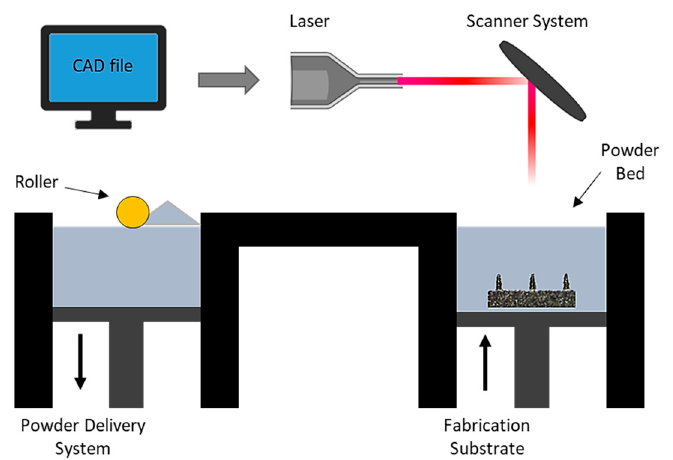
Figure 5. Schematic illustration of the DMLS process which is a layer by layer sintering process using a computer control to import the CAD file, while a laser beam directly melting the first layer of metal powder. A powder delivery system and a roller are used to apply the next layer of metal powder until the final part is produced [113].